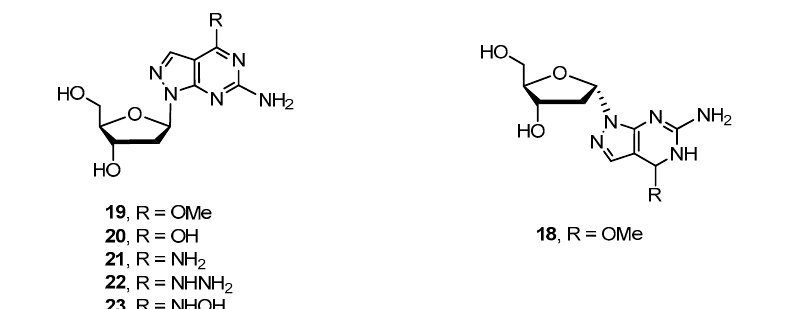
Figure 1. 8-Aza-7-deaza purine ribonucleosides.